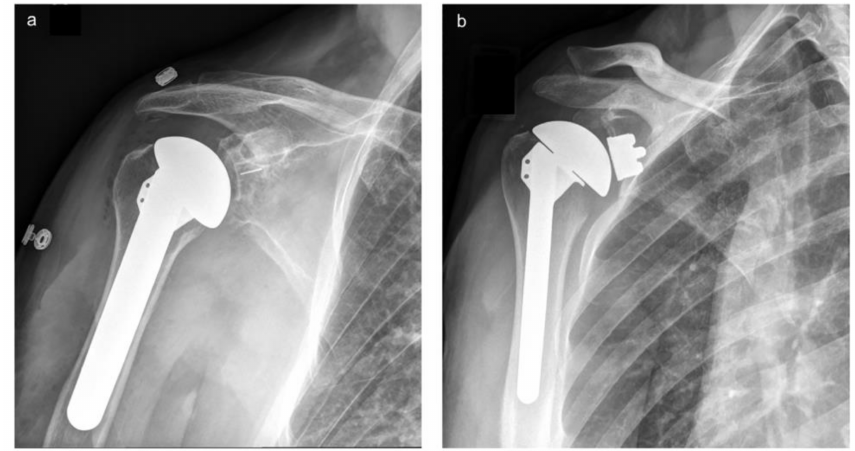
Figure 1. Radiographic images demonstrate an anatomic total shoulder arthroplasty of a right